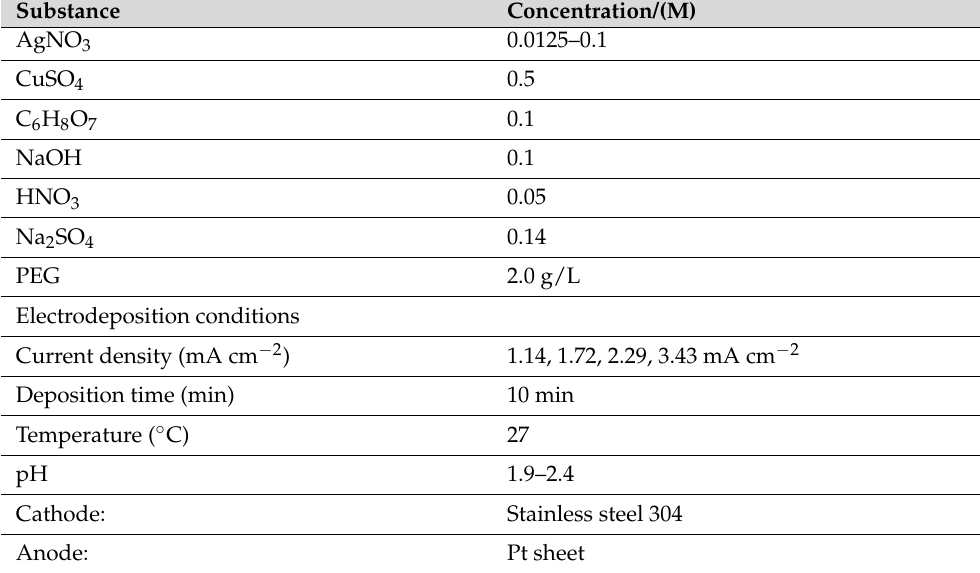
Table 1. The optimum bath composition for the ncCuAg co-deposition and the operating